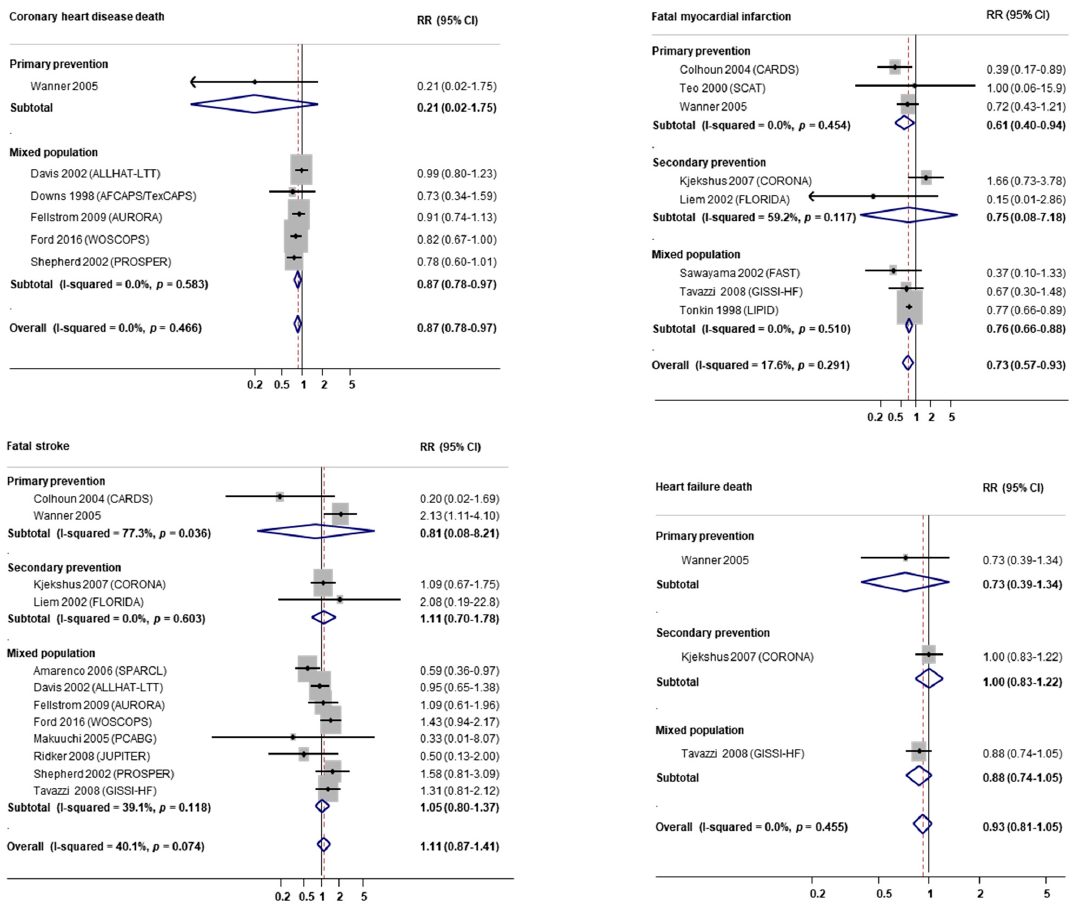
Figure A10. Subgroup meta-analysis for the effect of statins on specific causes of cardiovascular disease death. Full black quadrilateral represents the point estimate of individual studies and blank with quadrilateral represents pooled estimates. RR, relative risk; CI, confidence interval. Pooled estimates for the overall study population and subgroups are highlighted with bold